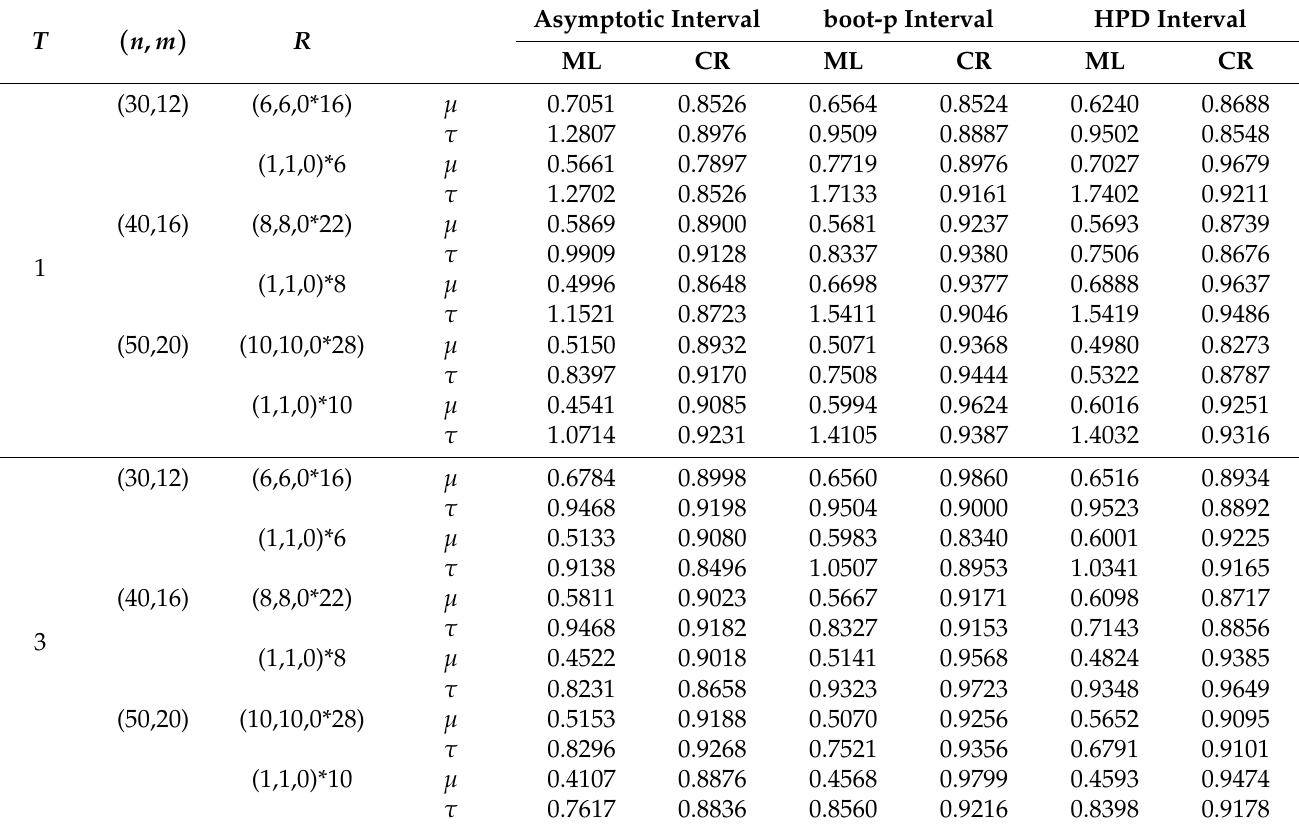
Table 4. Mean lengths (ML) and coverage rates (CR) of confidence intervals and credible intervals at the 95% credibility